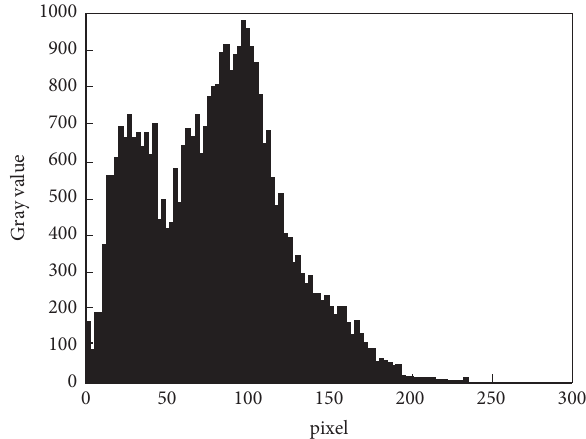
Figure 2: Histogram of original image.